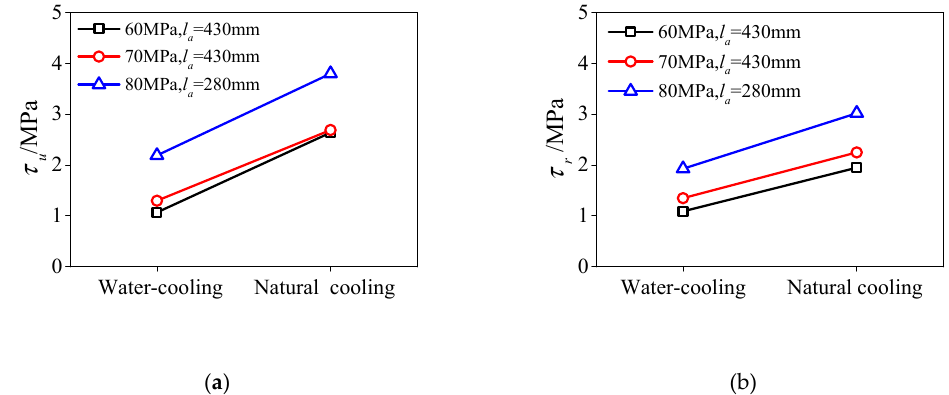
Figure 19. The e ff ect of cooling method on bond behaviors ( a ) ultimate bond strength; ( b ) residual bond